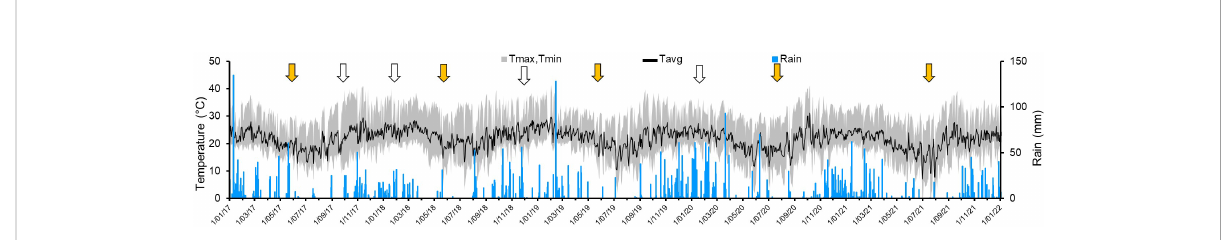
FIGURE 2 Daily records of temperatures (average: black line; amplitude: gray area) and rainfall (black bars) recorded in the farm located in the municipality of Rio Claro, SPS, Brazil, used to assess yield and fl ushing on 5-year-old ‘ Femminello ’ lemon and ‘ Valencia ’ sweet orange trees. Weeks of main and secondary fruit harvests are indicated by yellow and white arrows,